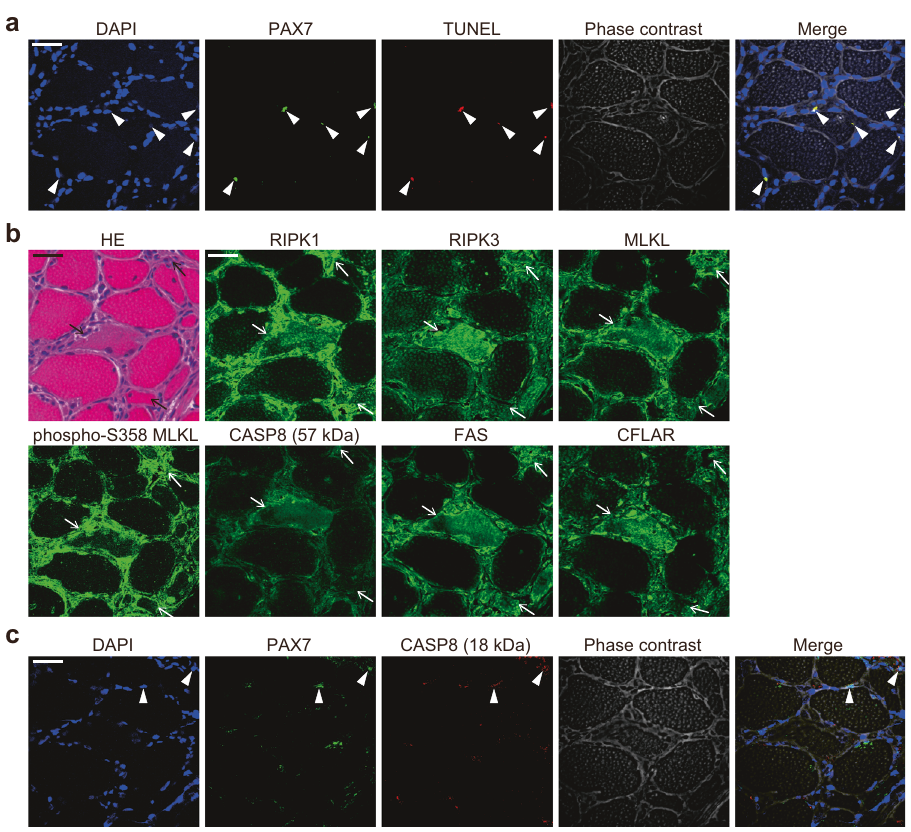
Fig. 1 Expression of necroptosis-associated proteins in dying muscle fi bers in PM. a – c Representative images of muscle specimens of PM patients ( n = 9). Scale bar indicates 20 μ m. a Immuno fl uorescence staining against PAX7 (green) and the TUNEL staining (red). Nuclei were counterstained with DAPI (blue). Arrowheads indicate TUNEL positive PAX7 positive satellite cells. b Hematoxylin & Eosin (HE) and immuno fl uorescence staining against RIPK1, RIPK3, MLKL, phosphorylated MLKL at S358 (phospho-S358 MLKL), CASP8 (57 kDa), FAS, and CFLAR (green). The arrows indicate the dying muscle fi bers, which showed reduced eosin staining in the cytoplasm. c Immuno fl uorescence staining against PAX7 (green) and active 18 kDa CASP8 subunit (red). Nuclei were counterstained with DAPI (blue). Arrowheads indicate active 18 kDa CASP8 subunit positive PAX7 positive satellite